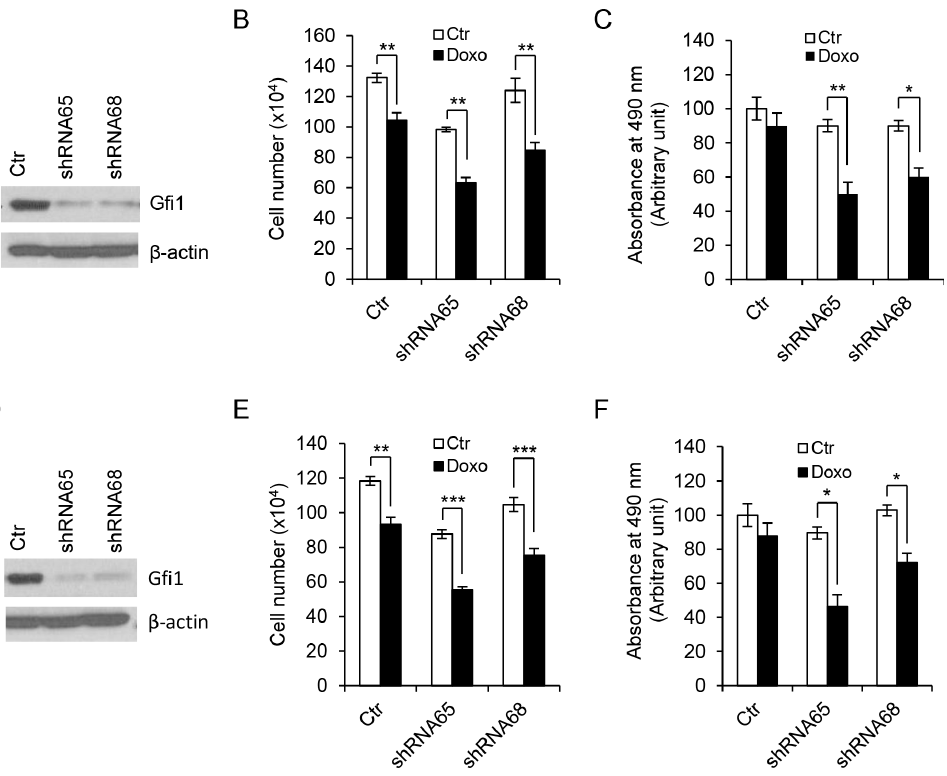
Figure 8. Knockdown of GFI1 increases cell death in response to DNA damage. U937 (A–C) and HL-60 (D–F) cells were transduced with empty lentivirus (Ctr) or lentiviruses containing two different shRNAs against GFI1 and examined for GFI1 expression by Western blot analysis (A and